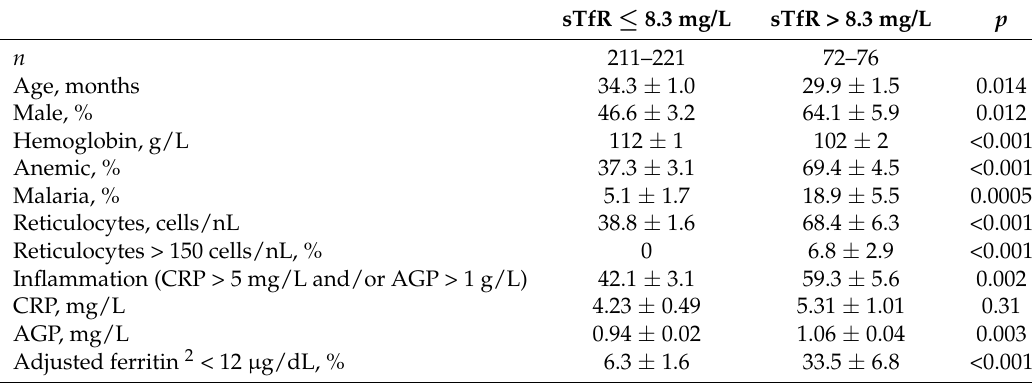
Table 4. Characteristics associated with elevated sTfR among children 12–59 months of age in Yaound é and Douala,